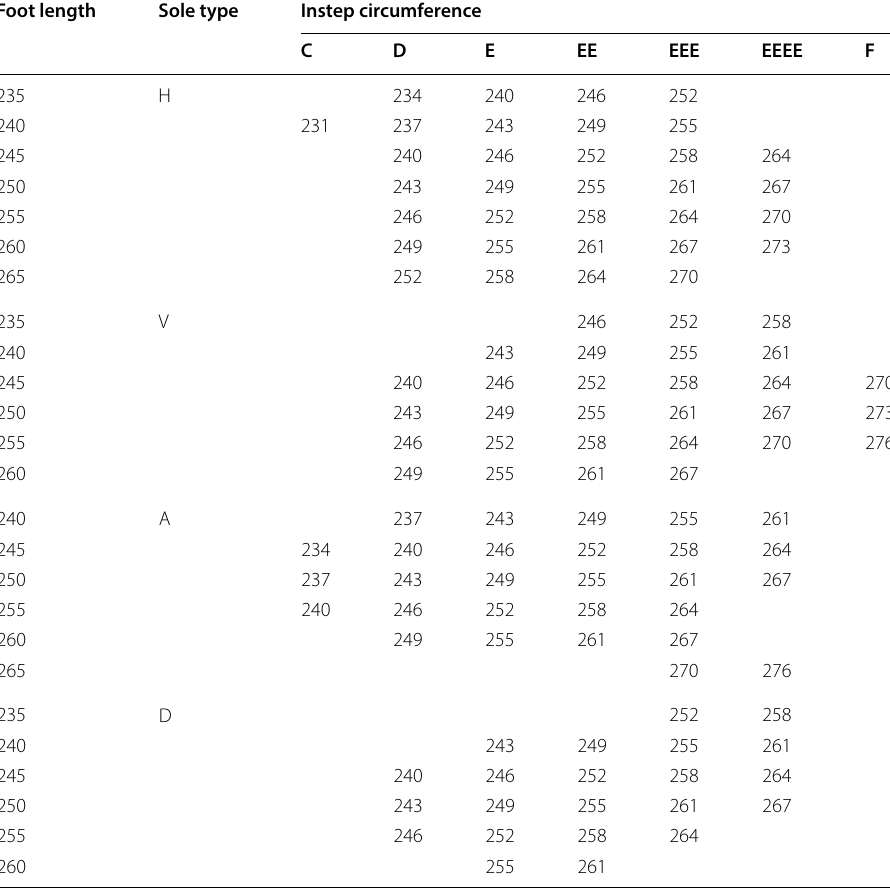
Length sizes start from 235 to 265 mm. There are seven instep circumference-sizes from C to F, which have step sizes of 6 mm